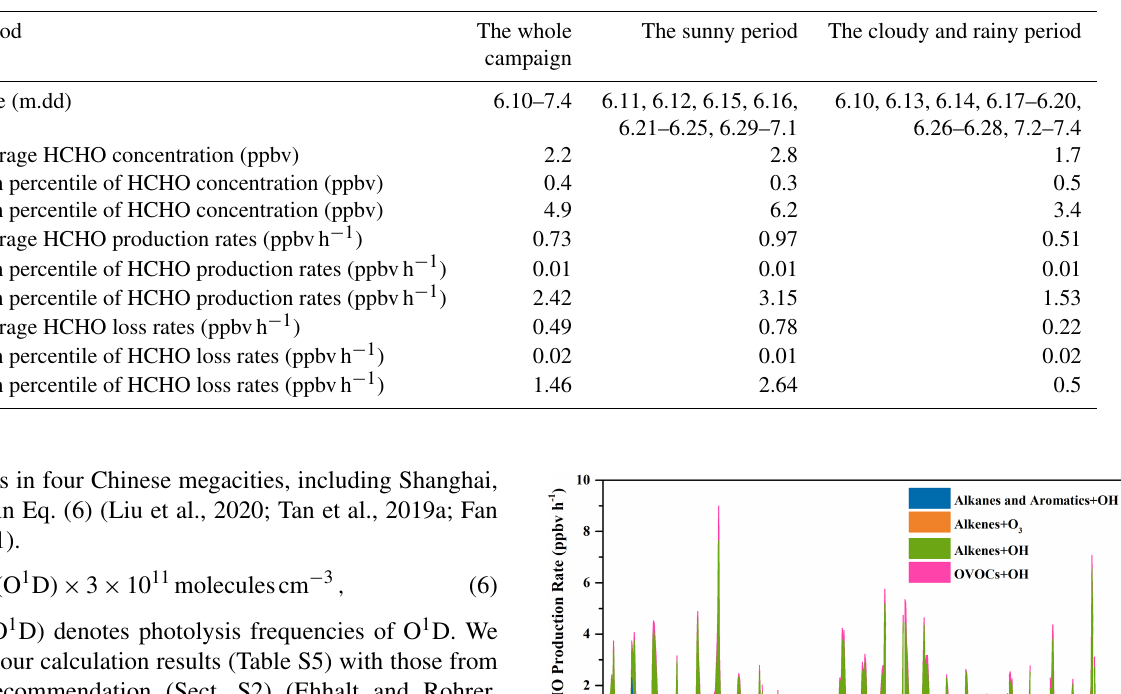
Table 1. Comparison of the HCHO concentration, HCHO production rates, and HCHO loss rates between the sunny period and the cloudy and rainy period.